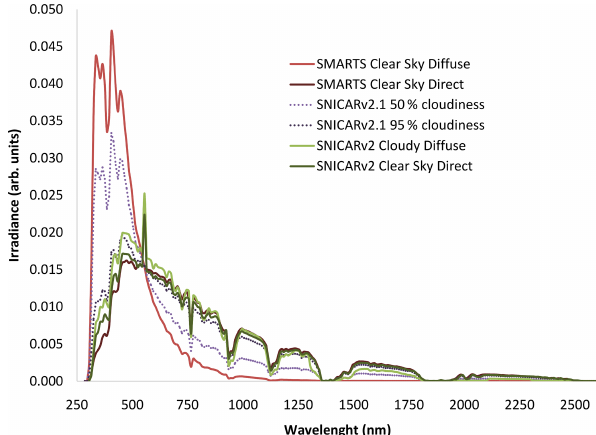
Figure 4. Different normalized spectral distributions of sun radi- ation for SNICAR snow albedo model. SNICARv2 included two spectra for mid-latitude locations: one for overcast conditions and one for clear-sky conditions. SNICARv2.1 allows calculation of dif- fuse spectra for partly cloudy conditions (50% and 95% cloud frac- tion are shown as examples). SMARTS diffuse and direct clear-sky spectra for one of our sampling sites are represented for compari-